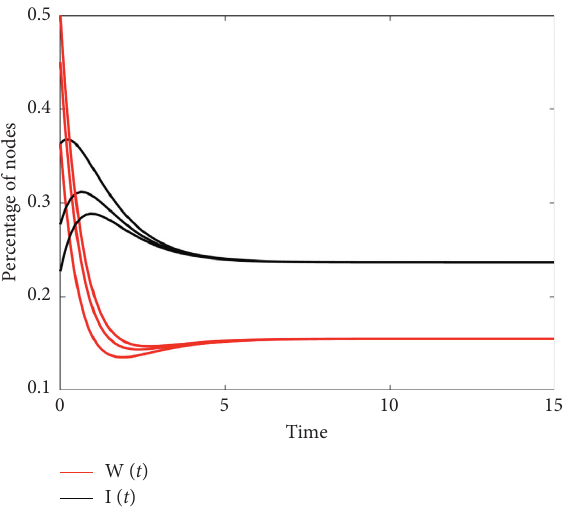
Figure 2: Time plot of model (5) with parameters and initial conditions set as in Example 1.